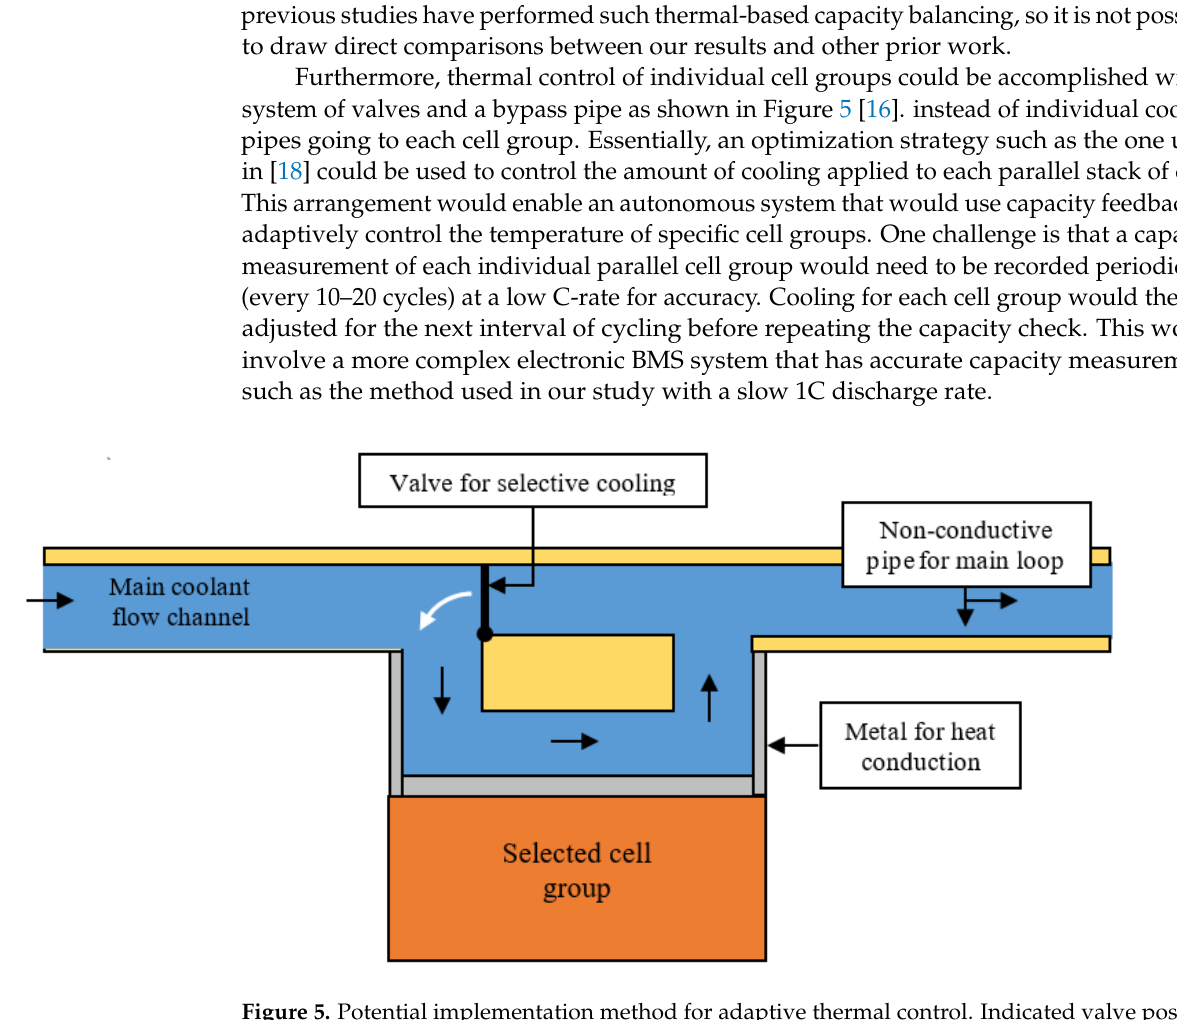
Figure 5. Potential implementation method for adaptive thermal control. Indicated valve position (open) directs coolant toward the selected cell group. Closing the valve would cause the coolant to bypass the cell group.